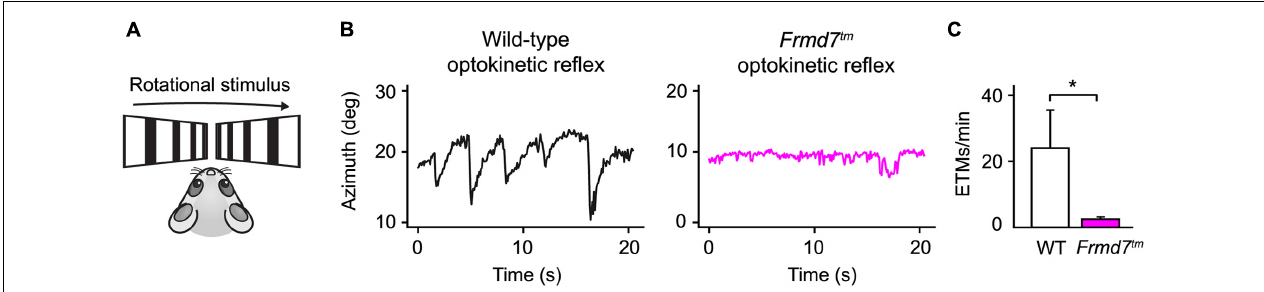
FIGURE 4 | The horizontal optokinetic reflex is absent in Frmd7 knockout mice. (A) Rotational motion simulation using gratings drifting in parallel along the horizontal axis. (B) Eye movements evoked by the optokinetic reflex in wild-type and Frmd7TM mice in response to drifting grating stimulation. The azimuth represents the horizontal angular coordinate of the eye. (C) The optokinetic reflex was quantified as eye-tracking movements per minute (ETMs), computed by thresholding the first derivative of eye movements, as described by Cahill and Nathans (Cahill and Nathans, 2008). Error bars show standard deviation. *P < 0.05, Wilcoxon signed-rank